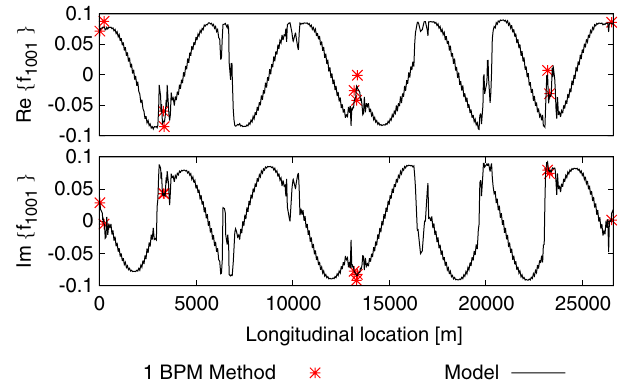
FIG. 8. Simulated coupling along the machine. The red markers indicate the reconstructed coupling using the 1 BPM method at the foreseen locations for the BPMs equipped with the DOROS electronics.